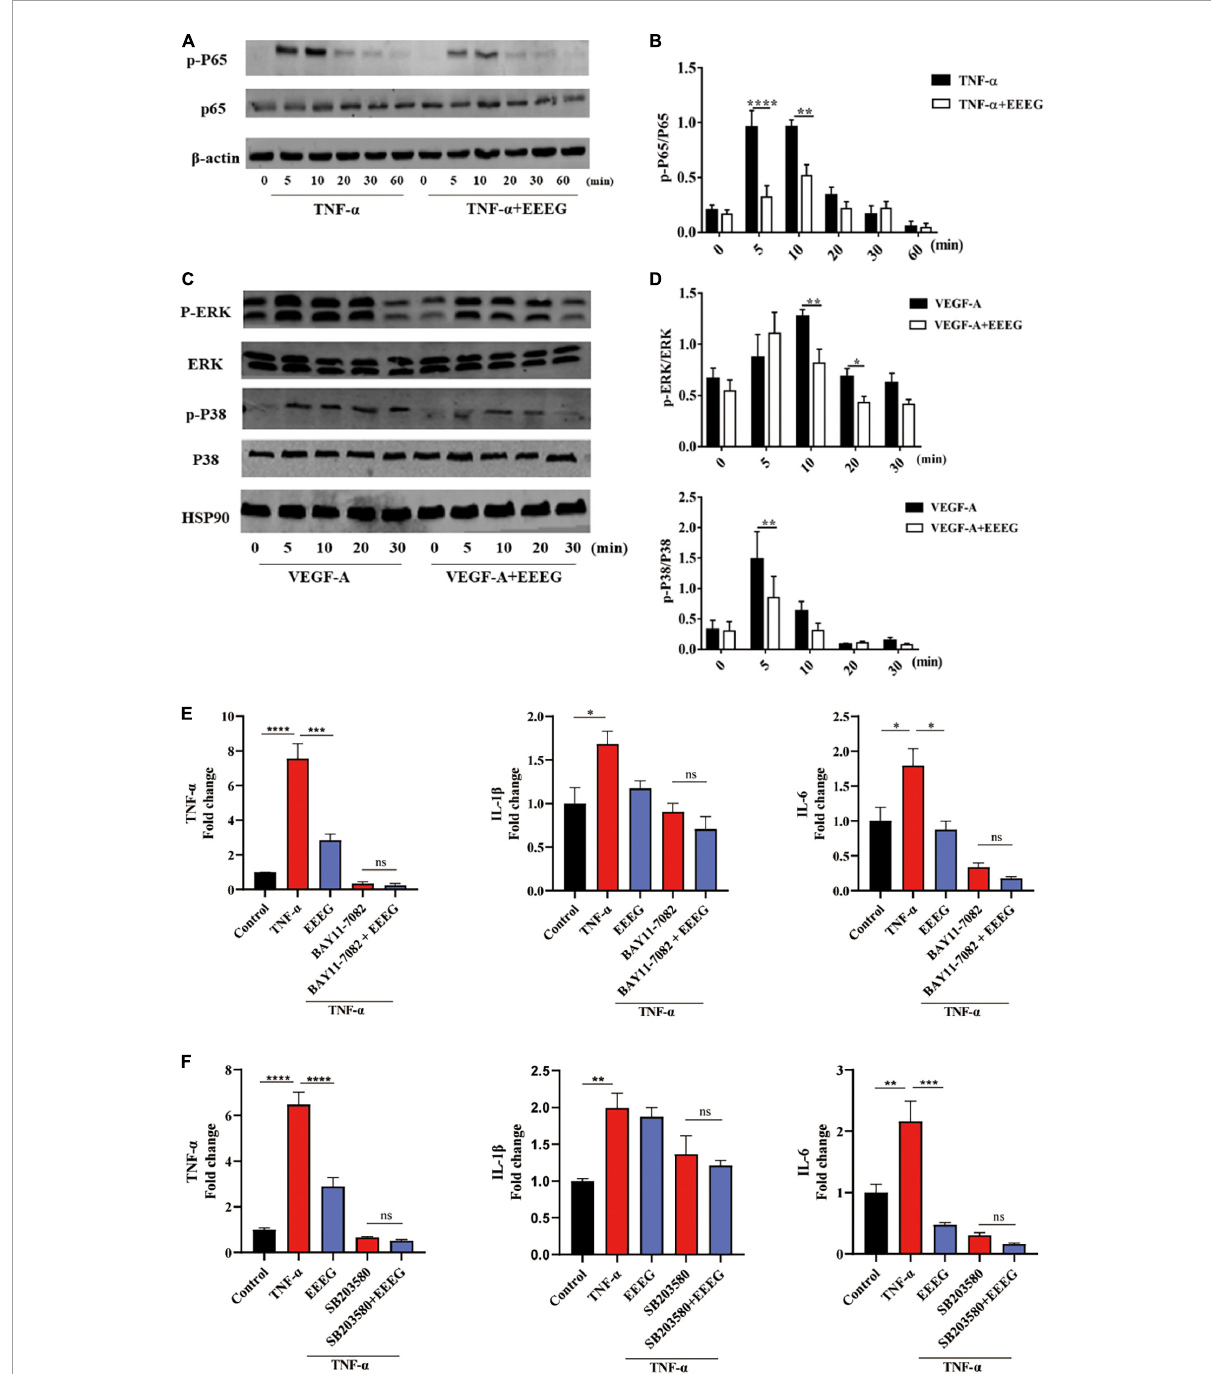
FIGURE5 EG extract (EEEG) inhibits endothelial pro-inflammatory activation by targeting NF- κ B and p38 MAPK signaling pathways. (A,B) Western blot analysis of the phosphorylation of p65 in HUVECs pretreated with or without EEEG (500 µ g/mL) for 24 h followed by TNF- α (10 ng/ml) stimulation for 0, 5 10, 20, 30, and 60 min (A) and quantification of phosphorylated p65 normalized to total p65 ( n = 3) (B) . (C,D) Western blot analysis of the phosphorylation of ERK and p38 MAPK in HUVECs pretreated with or without EEEG (500 µ g/mL) for 24 h followed by stimulation with VEGF-A (150 ng/ml) for 0, 5 10, 20, and 30 min (C) ; quantification of phosphorylated ERK and p38 MAPK normalized to total ERK and p38 MAPK ( n = 3) (D) . (E) Gene expression levels of Tnf- α , Il-1 β , and Il-6 in HUVECs pretreated with or without EEEG (500 µ g/mL) while in the presence or absence of NF- κ B inhibitor BAY11-7082 (5 µ M) for 24 h, followed by stimulation with or without TNF- α (10 ng/ml) for 4 h ( n = 3). (F) Gene expression levels of Tnf- α , Il-1 β , and Il-6 in HUVECs pretreated with or without EEEG (500 µ g/mL) while in the presence or absence of p38 MAPK inhibitor SB203580 (20 µ M) for 24 h, followed by stimulation with or without TNF- α (10 ng/ml) for 4 h ( n = 3). Data are mean ± SEM. * P < 0.05, ** P < 0.01, *** P < 0.001, **** P <